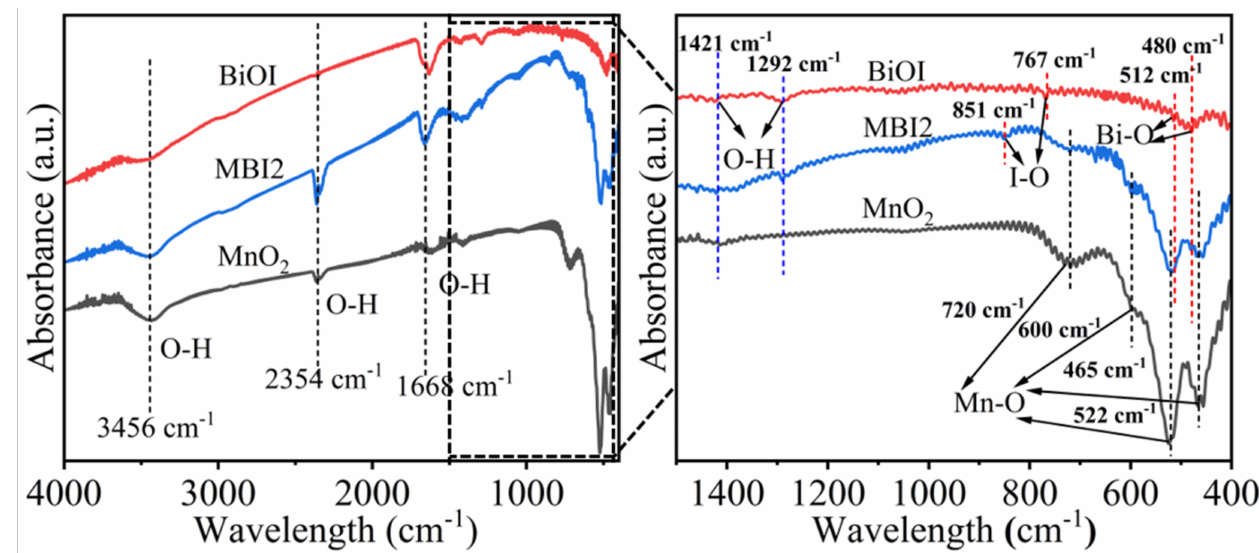
Figure 4. FT-IR patterns of pure α -MnO 2 , pure BiOI, and MBI2